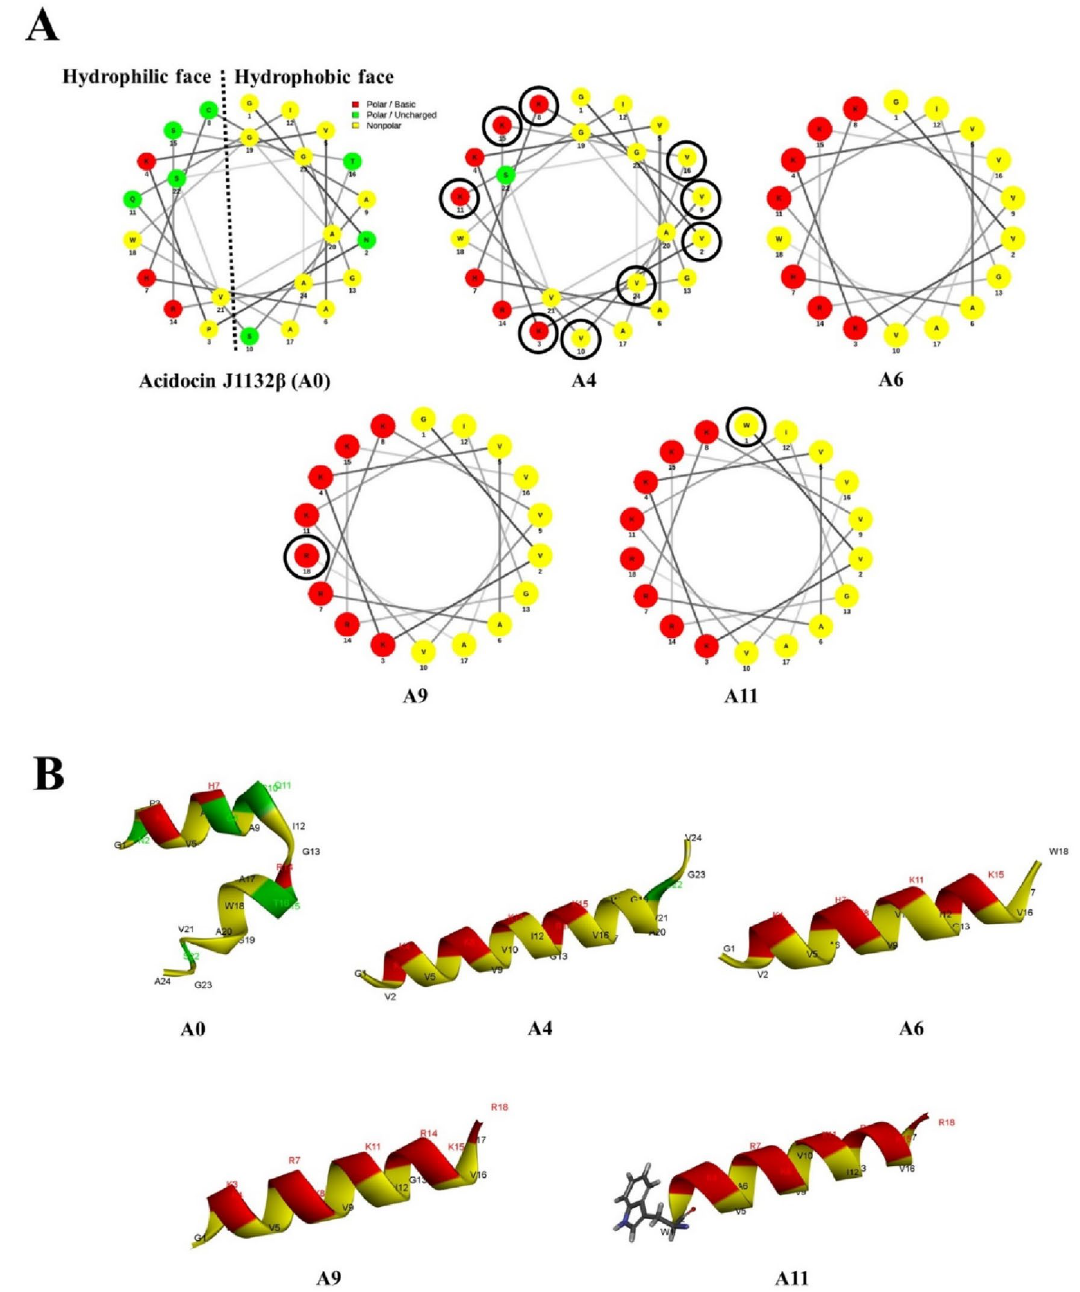
Figure 1. Helical wheel projections ( A ) and three-dimensional structure prediction ( B ) of designed acidocin J1132β peptide derivatives shown in ribbon diagrams. Positively charged, uncharged or polar, and hydrophobic residues are displayed in red, green, and yellow, respectively. The numbers depict the amino acid